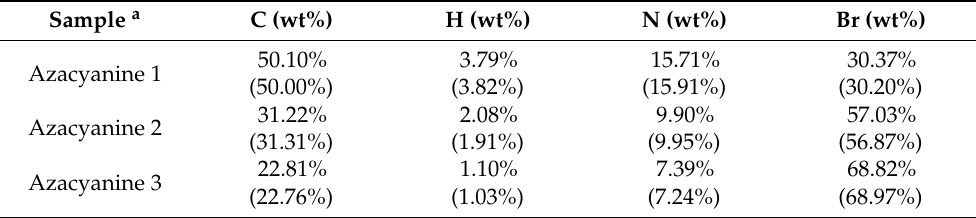
Table 1. The elements analysis results of products: Azacyanine 1, 2, and 3. Sample a